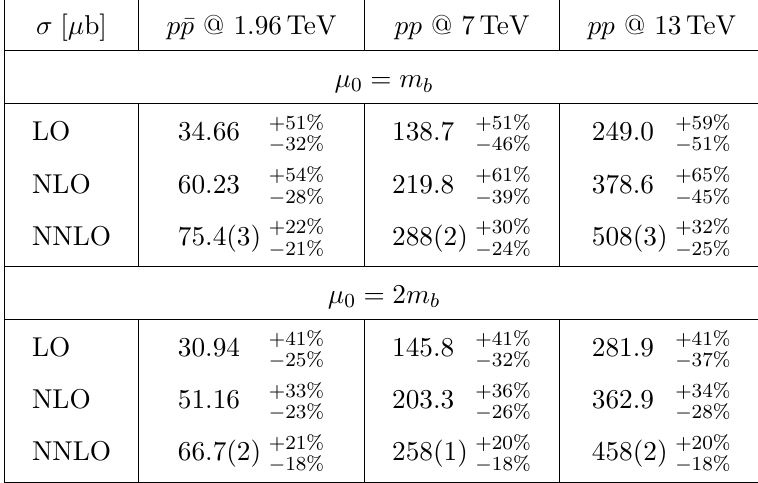
Table 2 . Total cross section for b (cid:22) b production at LO, NLO and NNLO. The quoted uncertainties are obtained through scale variations as described in the text. At NNLO the numerical errors on the last digits are stated in brackets, as in table